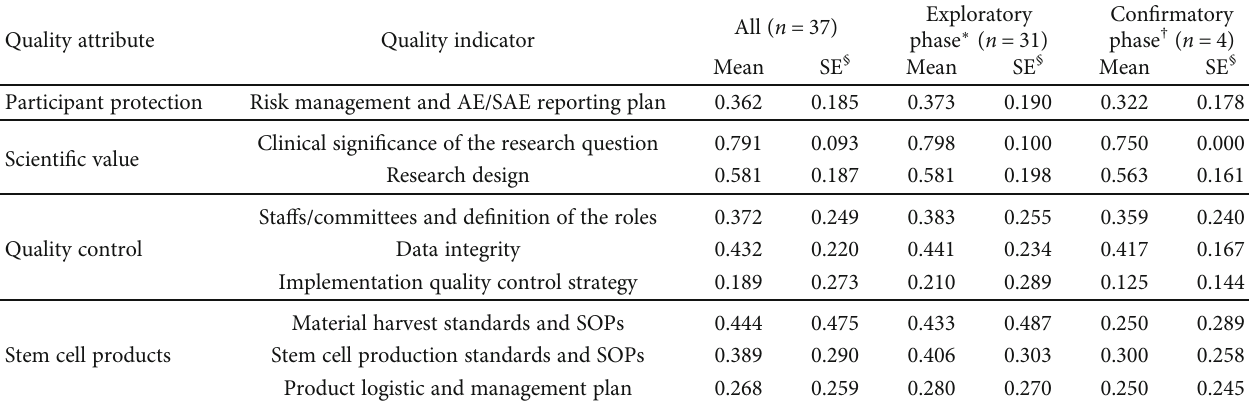
Table 3: Results from quality assessment tool for stem cell clinical trials by phases of trials. Quality